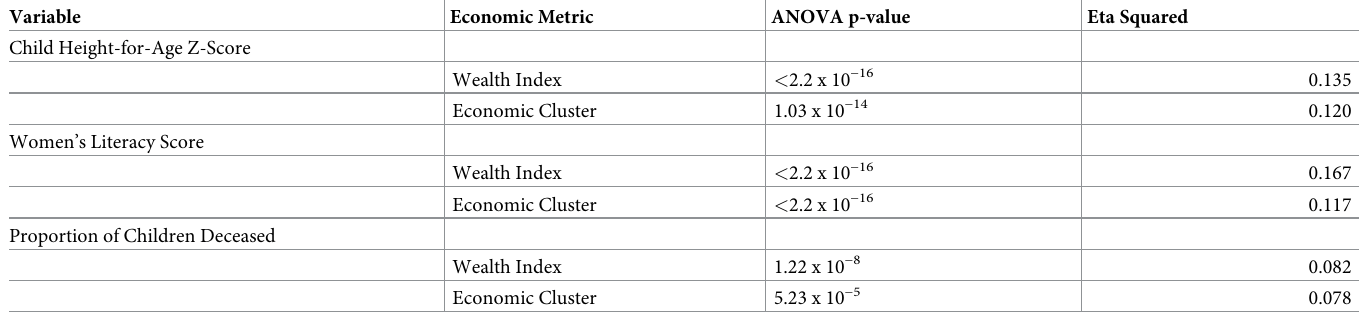
Table 2. Results of ANOVA and eta squared comparing proportion of variance in child height-for-age Z-score, women’s literacy score, and proportion of children who are deceased accounted for by Ghanaian DHS Wealth Index and EconomicClusters models.